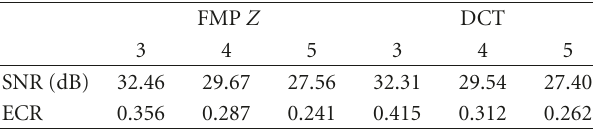
Table 6: Comparison for one-dimensional FMP and DCT.